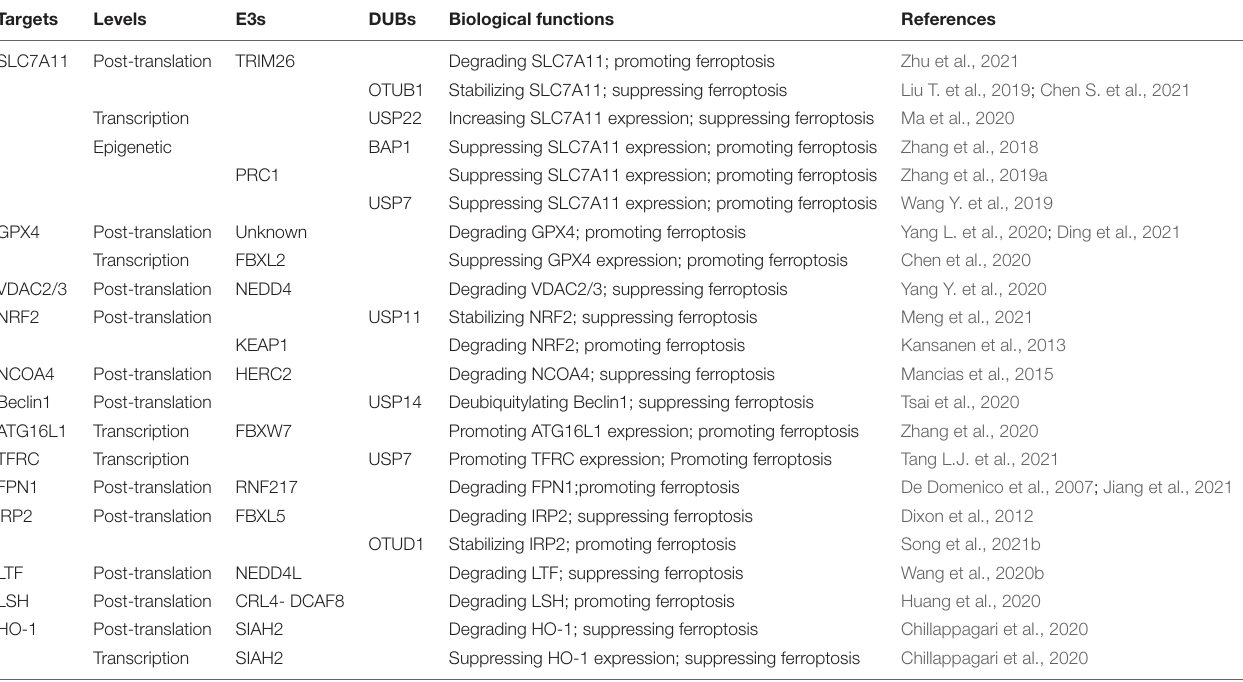
TABLE 1 | Ferroptosis regulation by E3s and deubiquitylating enzymes (DUBs).